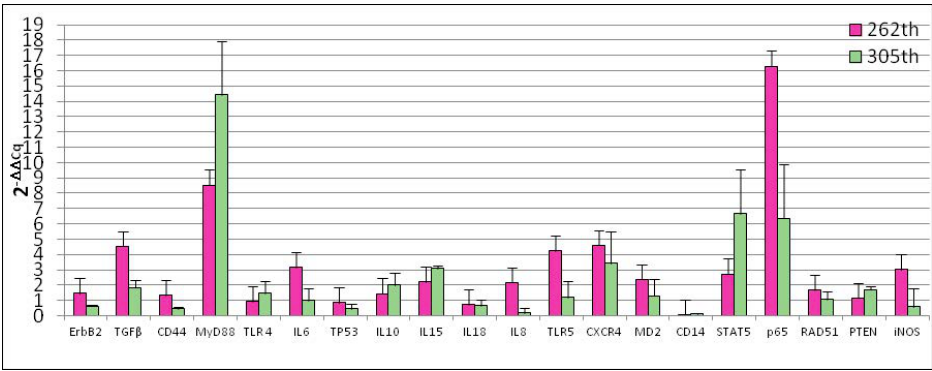
Figure 2. Effect of different passages on D-17 cells gene expression. Data are expressed as 2 - ΔΔ Cq ; values are the mean of three test replicates and ΔΔ Cq = Δ Cq (305th or 262th passage)— Δ Cq (control